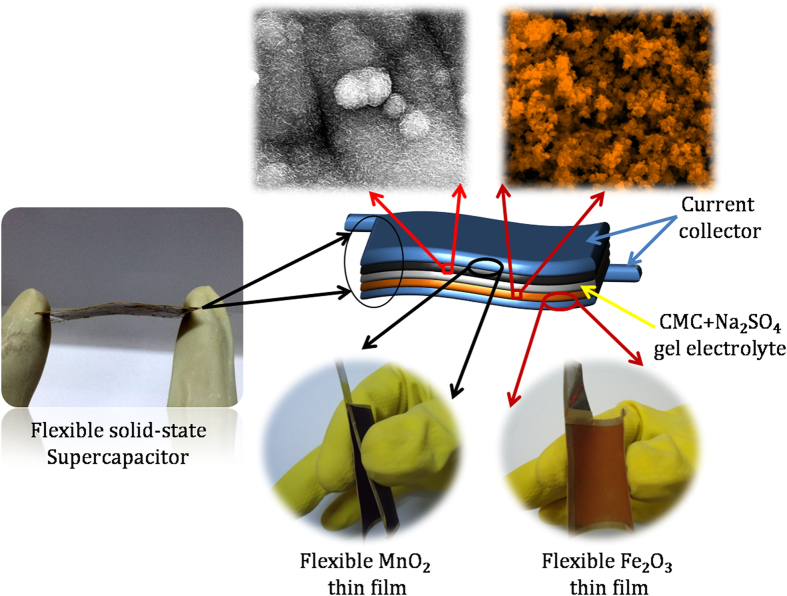
Schematic presentation of the fabricated asymmetric SC device based on flexible MnO2 NSs as positive electrode and Fe2O3 NPs as negative electrode with 1 M Na2SO4/CMC gel as separator and electrolyte.